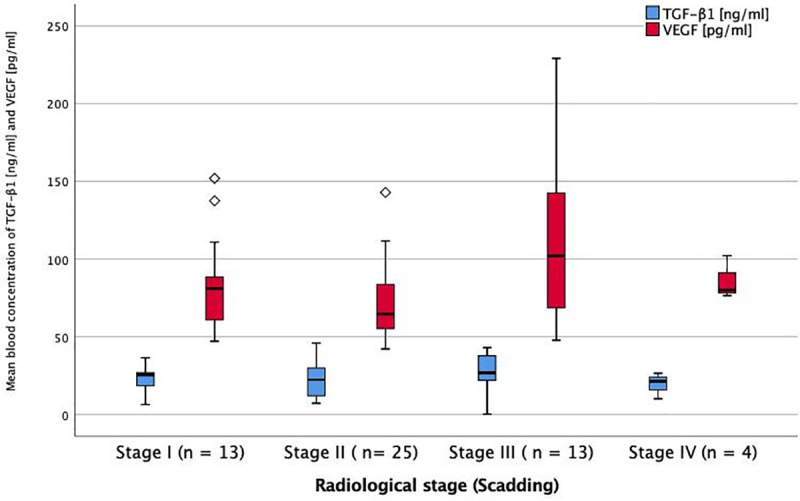
Serum levels of TGF-ß1 and VEGF in different radiological stages of sarcoidosis at baseline.Mean blood concentration of TGF-β1 and VEGF in different radiological stages of sarcoidosis. TGF-β1 = transforming growth factor beta-1. VEGF = vascular endothelial growth factor. * = p < 0.05 (ANOVA + Tukey-test as post-hoc test for multiple comparisons). No significant difference between groups.